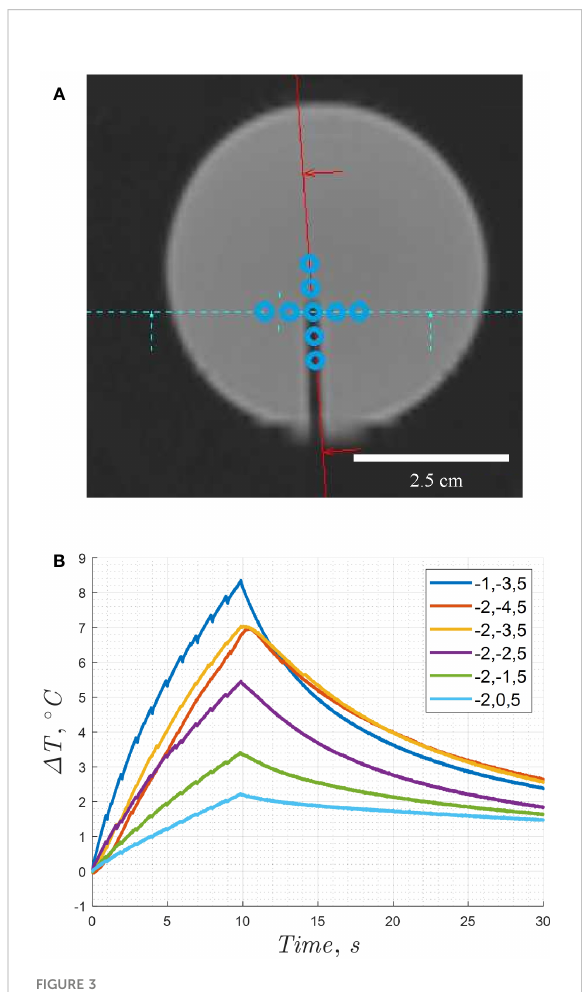
FIGURE 3 (A) Coronal view of MR image from a T1-VIBE sequence showing the position of the hydrophone needle within the tissue mimicking phantom sample. (B) Temperature increase compared to focal point coordinates, when controlled by electronic beam steering. Point (-1,-3,5) was chosen as the optimal location. Note, the estimated location of the focal spot relative to the sensor is within the distance of one voxel, providing a spatial precision of one-half voxel or 0.5 mm. The relative positions are enlarged to enhance visibility of the sonication